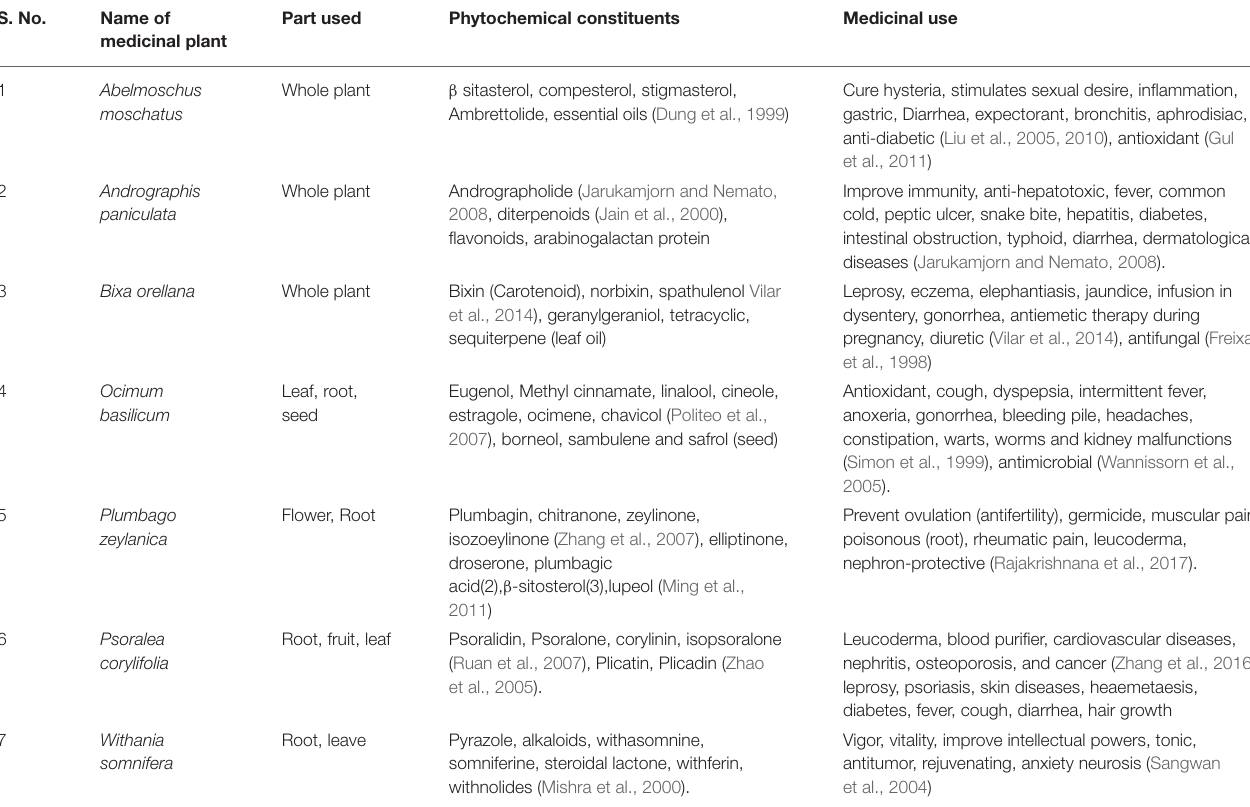
TABLE 1 | Summary of the phytochemical constituents and medicinal use of plants selected for the study. S.